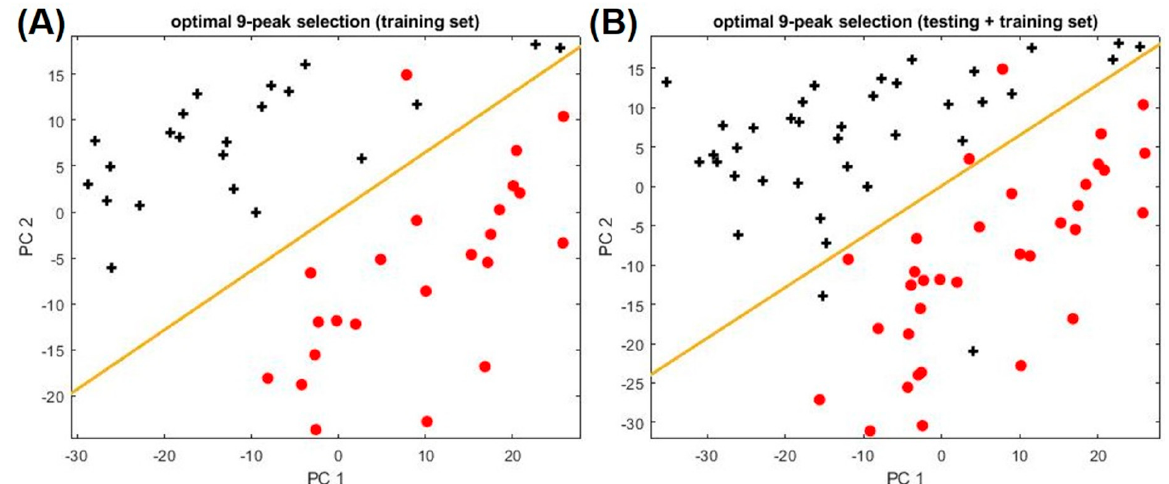
Figure 2. PCA plots using the optimal 9-peak subset (9 biomarkers) for distinguishing asthma from non-asthma/non-atopic